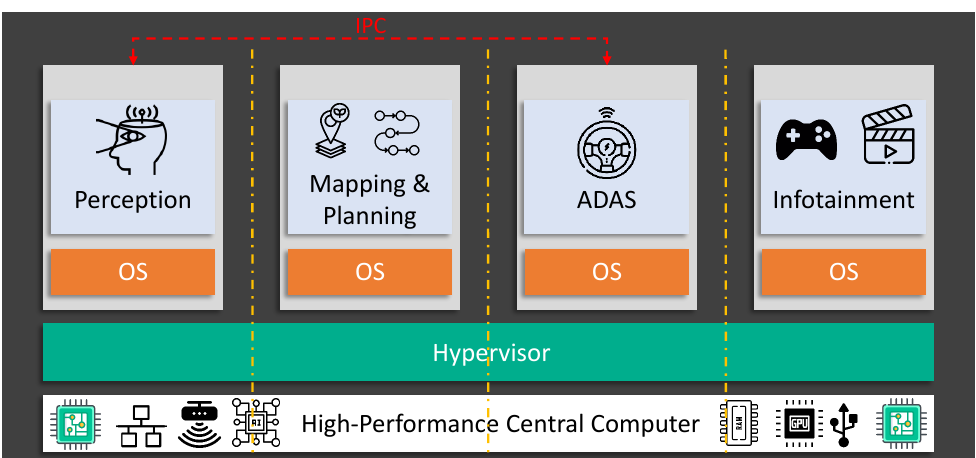
Figure 2. The software architecture integrated into the vehicle’s HPCU using a type-1 hypervisor which consists of four mixed-critical partitions. The yellow dash lines show the hard separations between partitions starting from the hardware